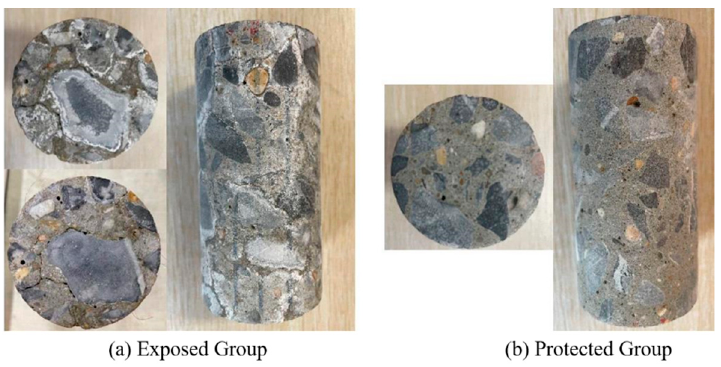
Figure 4. Changes in specimen